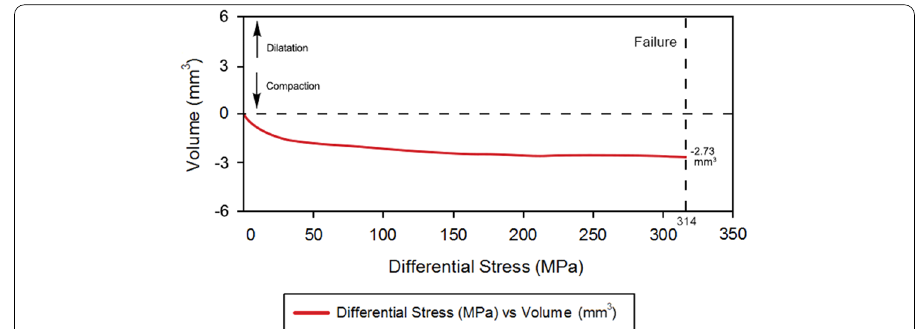
Fig. 6 Pore volume change with increasing differential stress during the triaxial test